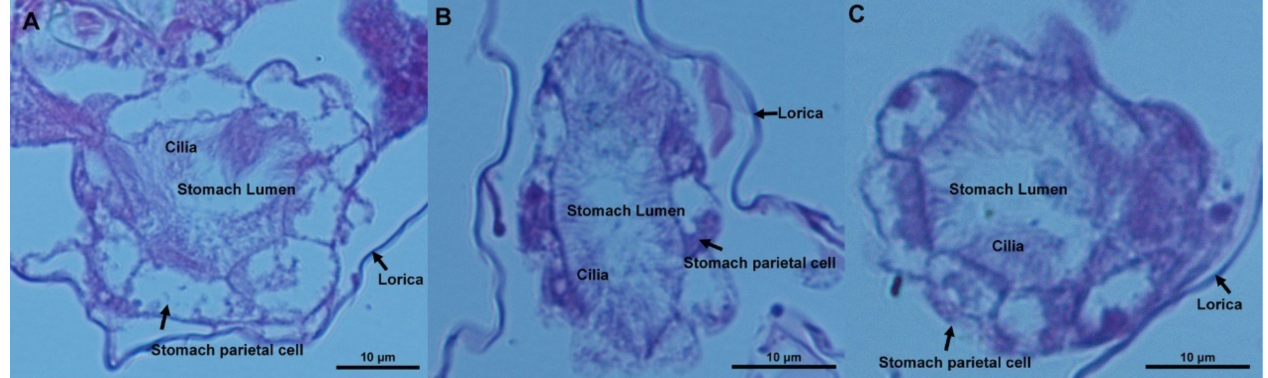
Figure 2. Microstructural images of rotifer stomach in the control group ( A ), 0.1- µ m MP group ( B ), and 1- µ m MP group ( C ). The hyperchromatic areas represent the nuclei of the stomach parietal cells of Brachionus because they were